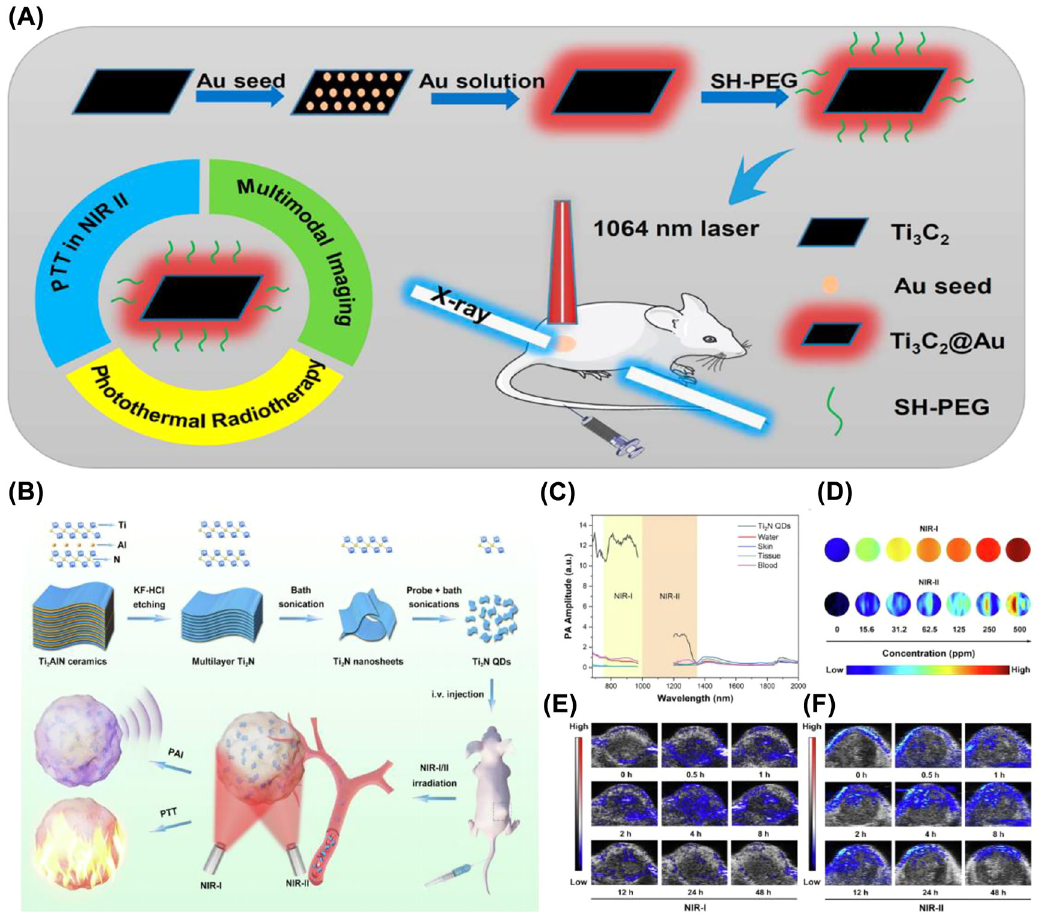
C @Au synthesis and PA/CT dual-modality imaging-guided treatment [47]. Figure 5: PA imaging of MXene. (A) Schematic diagram of Ti 3 2 N QDs synthesis and the role of PTT guided by PA imaging in NIR-I/II Copyright 2019, American Chemical Society. (B) Schematic diagram of Ti 2 N QDs in NIR-I/II regions by taking different samples (water, skin, tissue, and blood of mice) as the biological windows. (C) PA signals of Ti 2 N QDs at various concentrations (from 0 to 500 ppm) irradiated by 808 and 1280 nm laser. (E–F) In control group. (D) In vitro PA images of Ti 2 vitro PA images in tumor tissue after intravenous injection [26]. Copyright 2020,